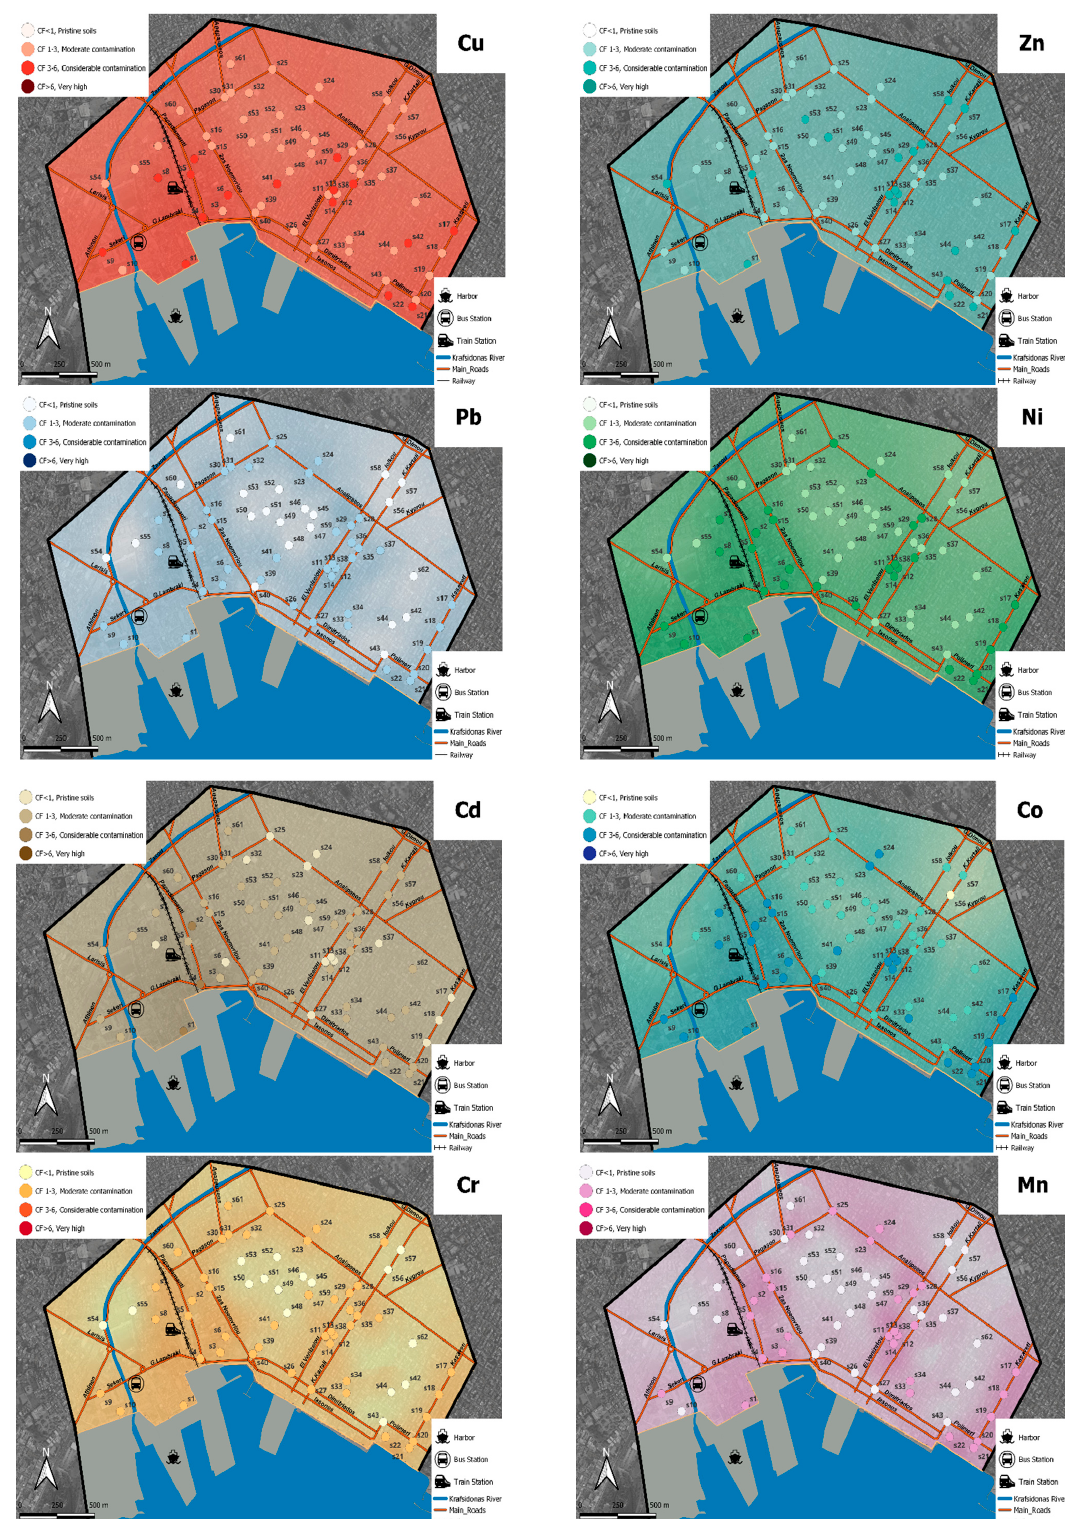
Figure 1. Thematic maps of heavy metals based on contamination factor (CF) values in Volos before the COVID ‐ 19 pandemic (mean values for the four years of the study, n = 248).